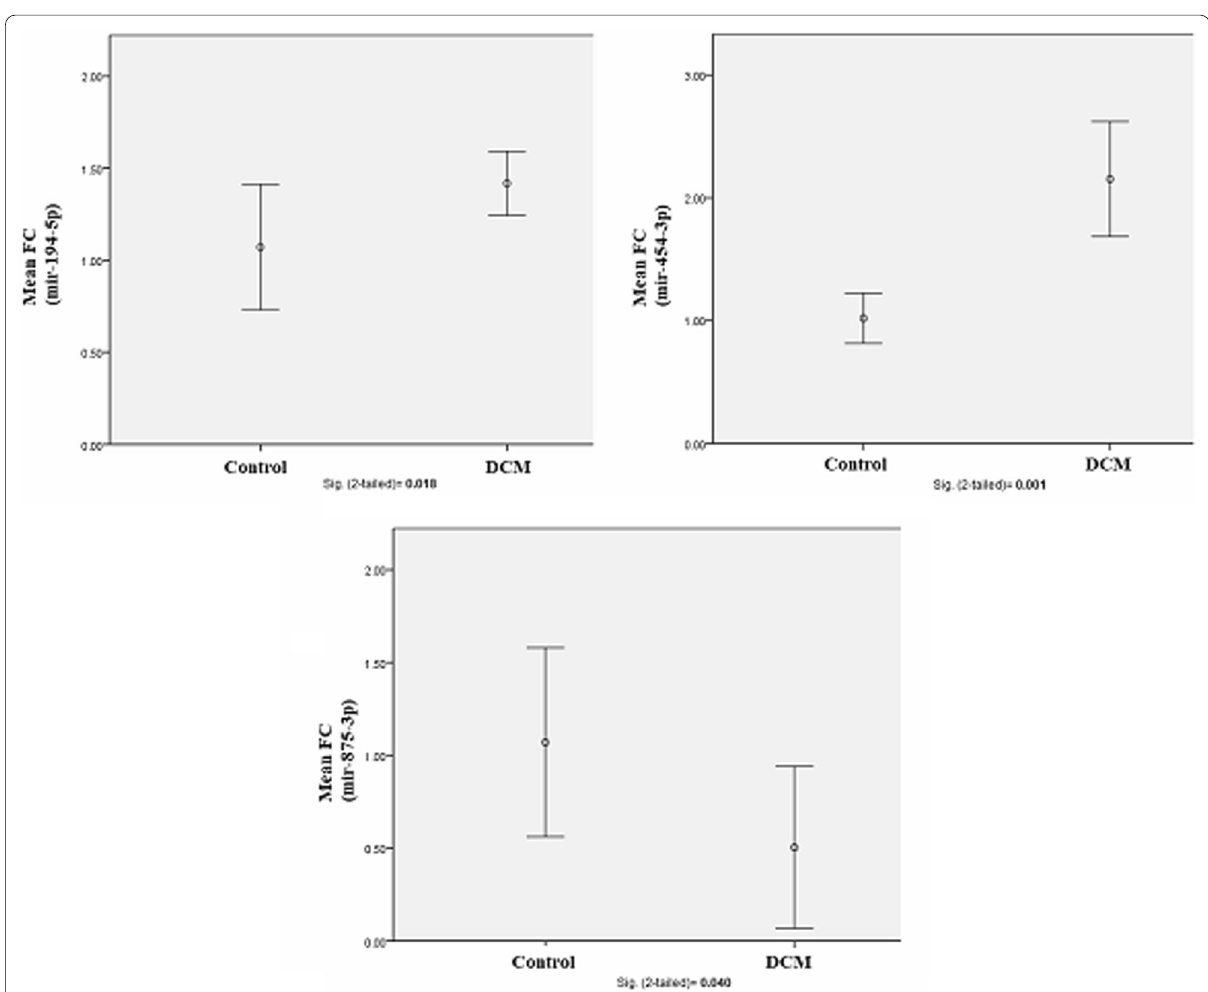
Fig. 1 Error bars for distribution of fold change (FC), quantified by ∆Ct, of plasma miR‑194‑5p, miR‑454‑3p and miR‑875‑3p between DCM cases and controls. p value was calculated by independent t test; significant p value